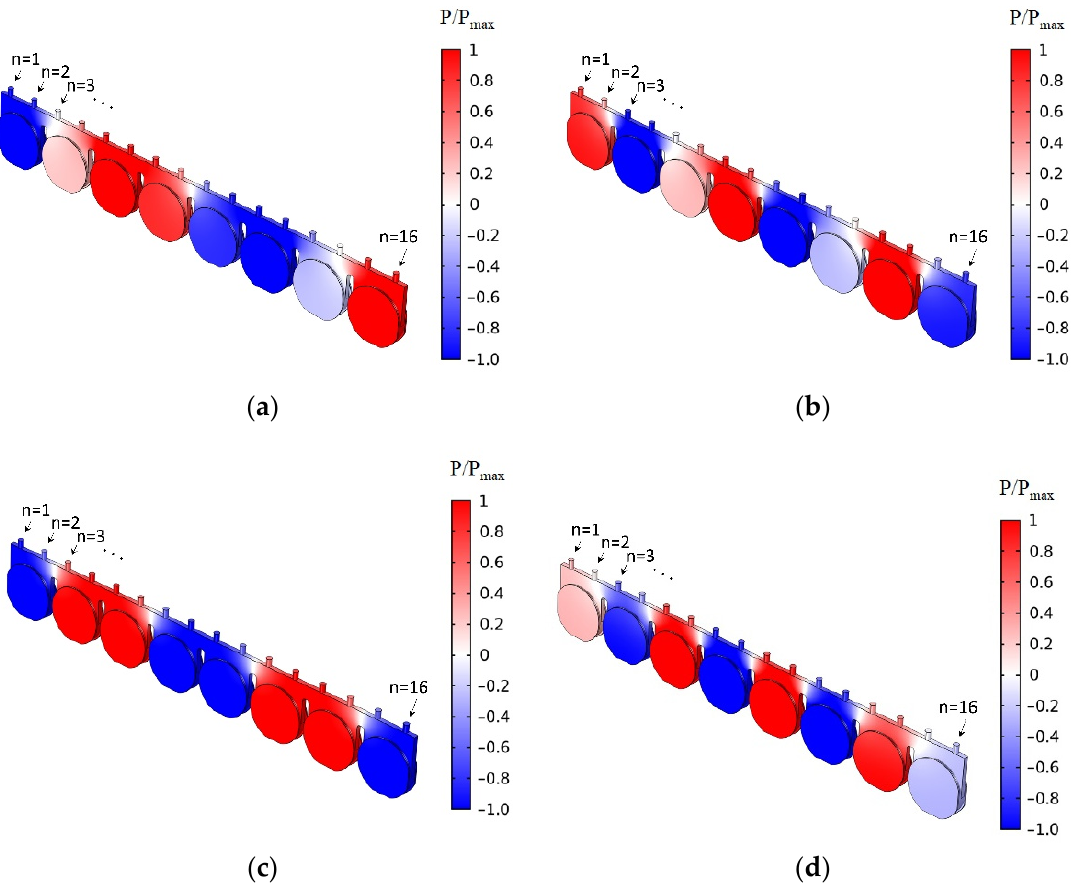
Figure 9. Results of acoustic simulations showing the instantaneous acoustic-pressure distribution, i.e., acoustic mode, within the unified, large-aspect-ratio-cavity volume for different natural frequencies. The frequencies are ( a ) f s 1 = 956 Hz, ( b ) f s 2 = 1126 Hz, ( c ) f s 3 = 1252 Hz, and ( d ) f s 4 = 1331 Hz.